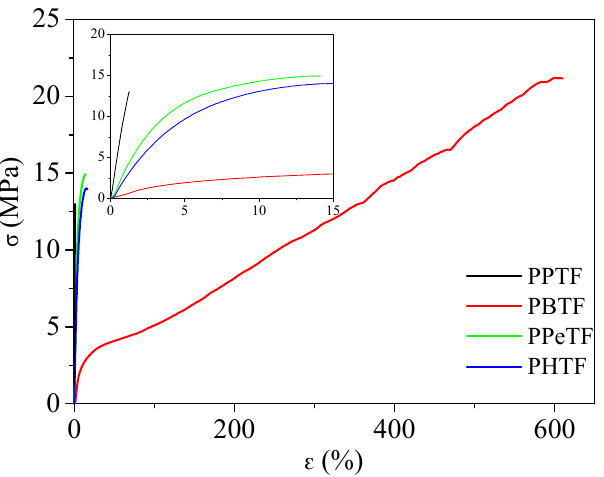
Figure 6. Stress–strain curves of PPTF, PBTF, PPeTF and PHTF films after 3 weeks of storage at room temperature.